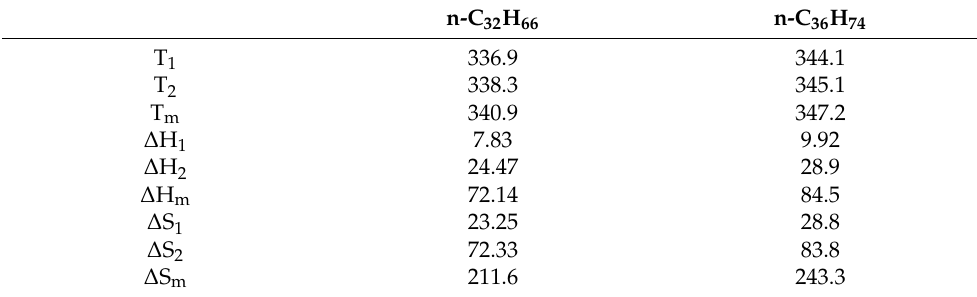
Table 2. Restatement of Data of Table 1 in Units of Molar Quantities and Absolute Tempera- tures